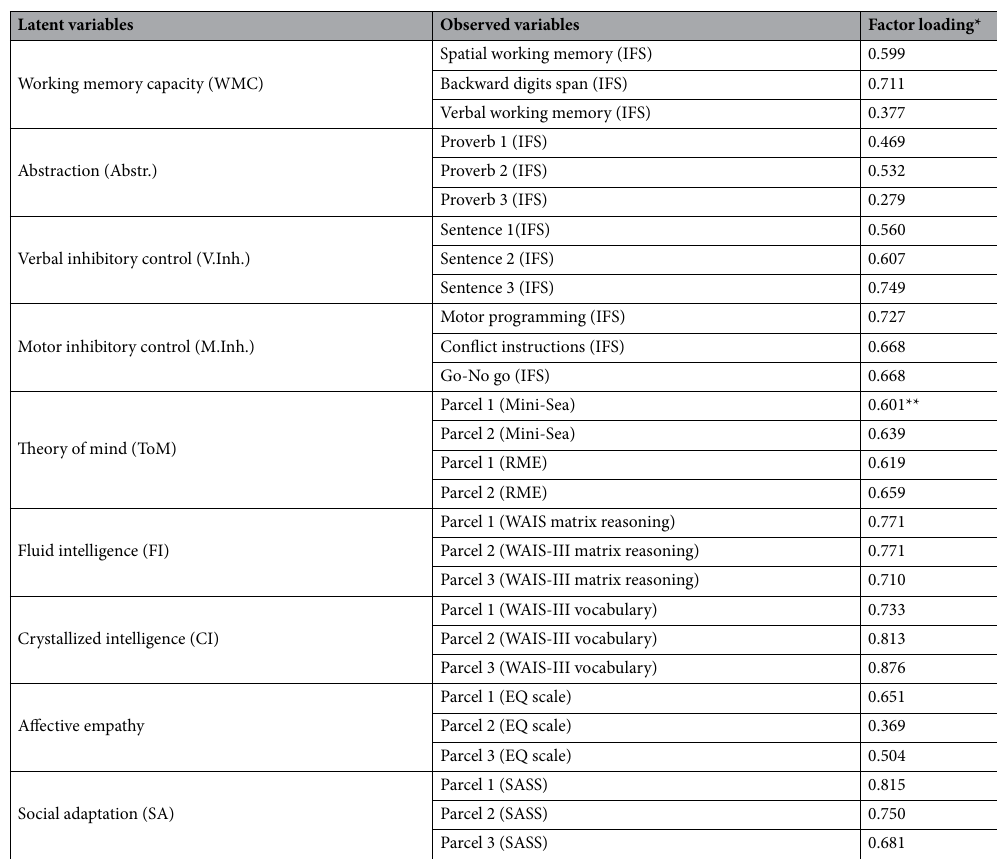
Table 1. Factor loadings for the observed variables in the SEM model. Parcels were constructed for Mini-Sea, RME, WAIS-III matrix reasoning, EQ scale and SASS; we followed one strategy suggested by 78 . Specifically, parcels were constructed for reducing unwanted correlations between residual variances; that is, items with correlated residual variances were allocated to the same parcel. This strategy of parceling can create indicators with better measurement properties 78 . IFS INECO frontal screening test, RME reading the mind in the eyes test, WAIS-III wechsler adult intelligence scale III, EQ scale empathy quotient, SASS Social Adaptation Self-evaluation Scale. All factor loadings were statistically significant (p < 0.05). *Factor loadings between 0.0– ± 0.20, ± 0.21– ± 0.40, ± 0.41– ± 0.60, ± 0.61–0.99, and 1.0 were considered weak, low, moderate, strong, and perfect, respectively 79 . **The model included a covariance parameter between the residual variances of Parcels 1 and 2 of Mini Sea.